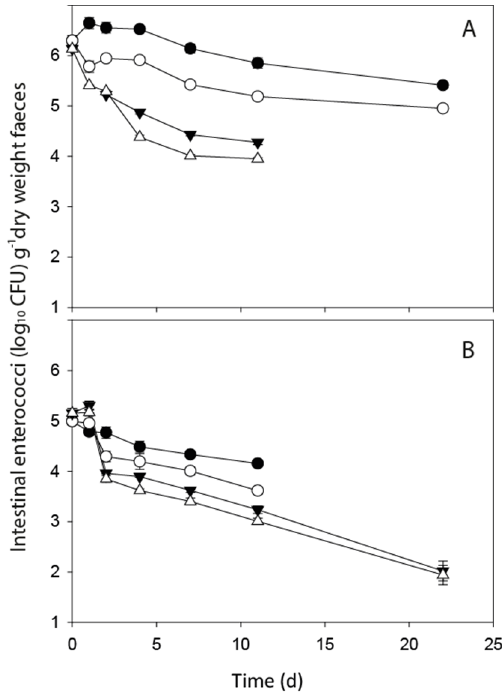
Figure 2. Intestinal enterococci die-off profiles in dairy faeces ( A ) and deer faeces ( B ) held at: constant 4 °C (solid black circle); −4 °C freeze–thaw (open circles); constant 0 °C (solid triangle); −8 °C freeze-thaw (open triangles). Data points are the mean of five replicates ± standard error (freeze–thaw) and three replicates ± standard error (constant). Table 1. FIO concentrations in fresh faeces from the dairy cow and red deer sources used in this experiment.